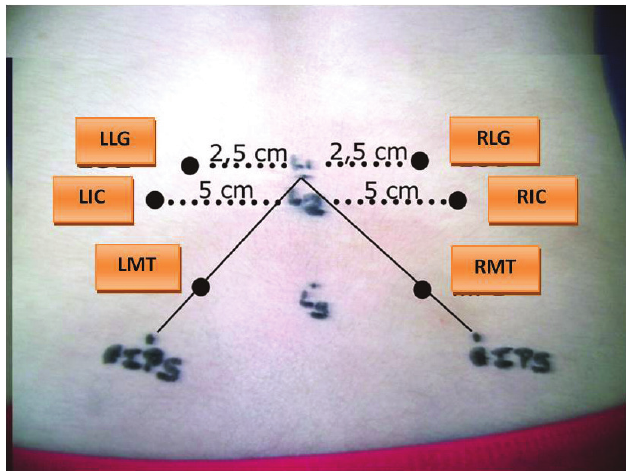
Figure 2. Top view of the set points for connecting the electrodes (MT: multifidus, LG: lumbar longissimus, IC: iliocostalis, R: right and L: left).